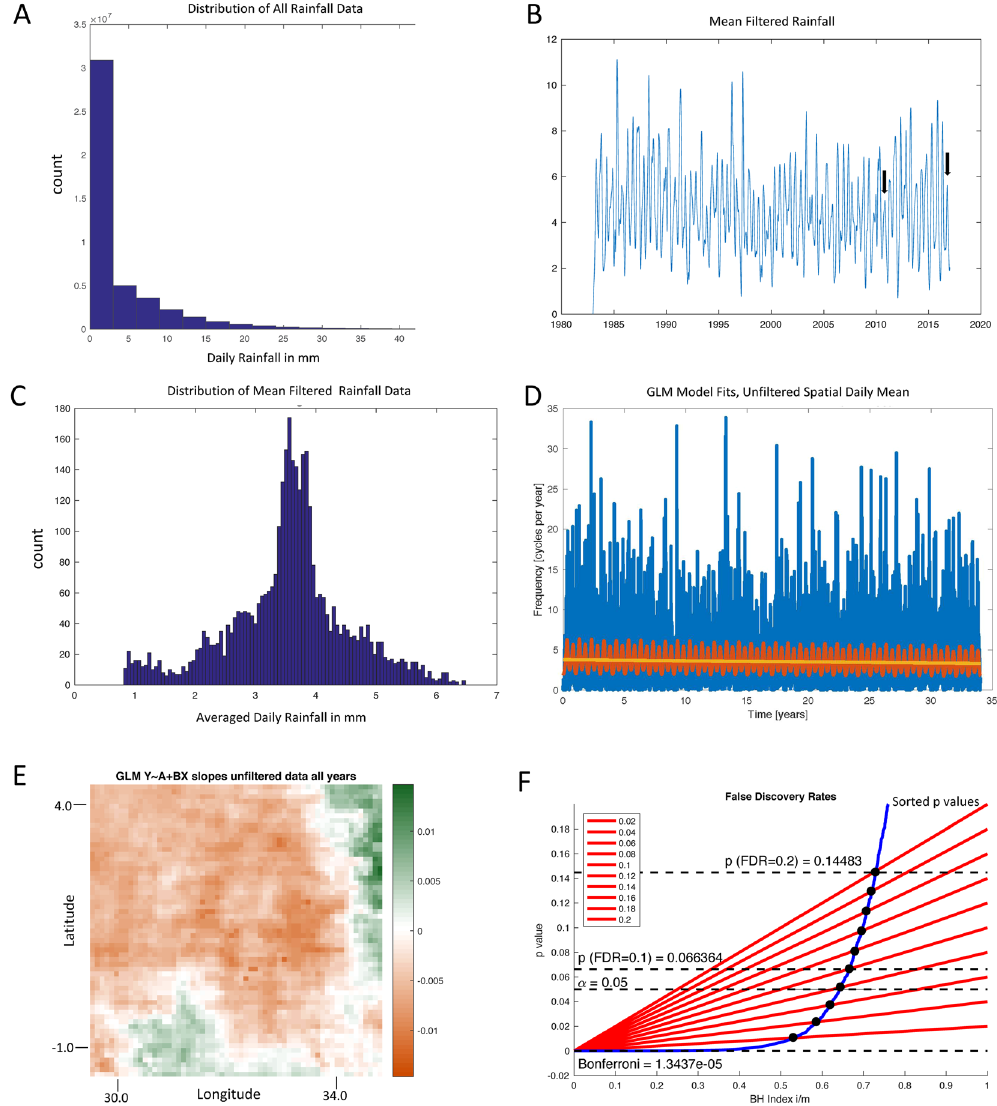
Figure 2. Spatially averaged rainfall demonstrates a decrease over the 34 year record. The nature of the data with and without spatial averaging is shown, and the origin of the average decrease in rainfall explained by the geographical distribution of decreases and increases in rainfall. ( A ) Histogram of daily rainfall for all days and locations, truncated below 40 mm rain per day. ( B ) Daily rainfall spatially averaged, and filtered with finite impulse response filter (order 100) for frequencies 0.05–6 cycles per year. Filter applied with zero phase filtering forwards and backwards. The twice-yearly rainy seasons in the East African Highlands are now plainly seen. Two drought anomalies from droughts in fall rainy season failures are indicated for 2010 and 2016 with black arrows. The averaged and filtered data set from B demonstrates a much less skewed distribution in ( C ). ( D ) Linear GLM fit, log( μ ) = A + BT, shown by yellow line, and full model fitted with 0.25, 0.5, 1, 2, and 4 cycle per year frequencies shown by red line, superimposed on spatially averaged but unfiltered data in D. In E are shown the individual slopes of linear GLM regression to each grid point time series, with no averaging, on a scale illustrating the intensity of the negative (brown) or positive (green) slopes. Map created using ArcGIS 10.4.1, http://support.esri.com/Products/Desktop/ArcGIS-desktop/arcmap/10-4-1. ( F ) False Discovery Rate (FDR) plot for the GLM fit p-values from the slope plot in E, for a family of FDR values. The intersections of the sorted p-values (blue) with the Benjamini-Hochberg coefficients (red lines) form the FDR thresholds employed in Fig.